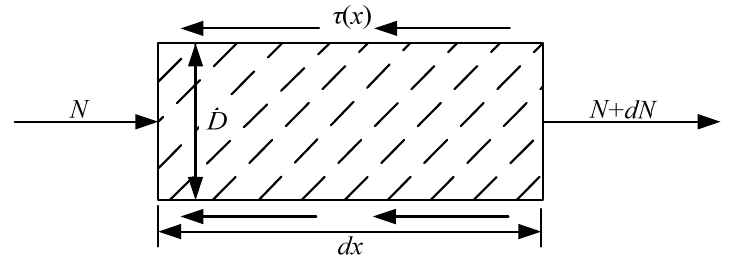
Figure 5. Mechanical model of a bolt element.